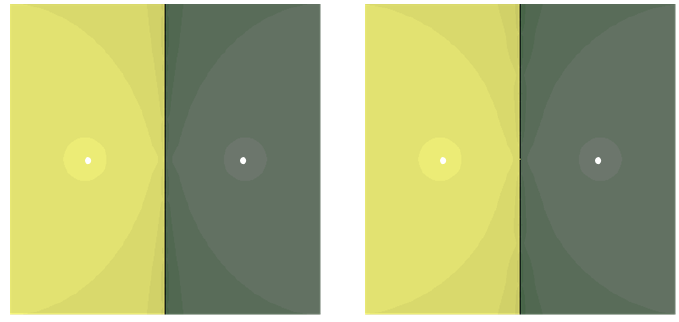
Figure 6. Basins of attractions for (23) on left and (24) on